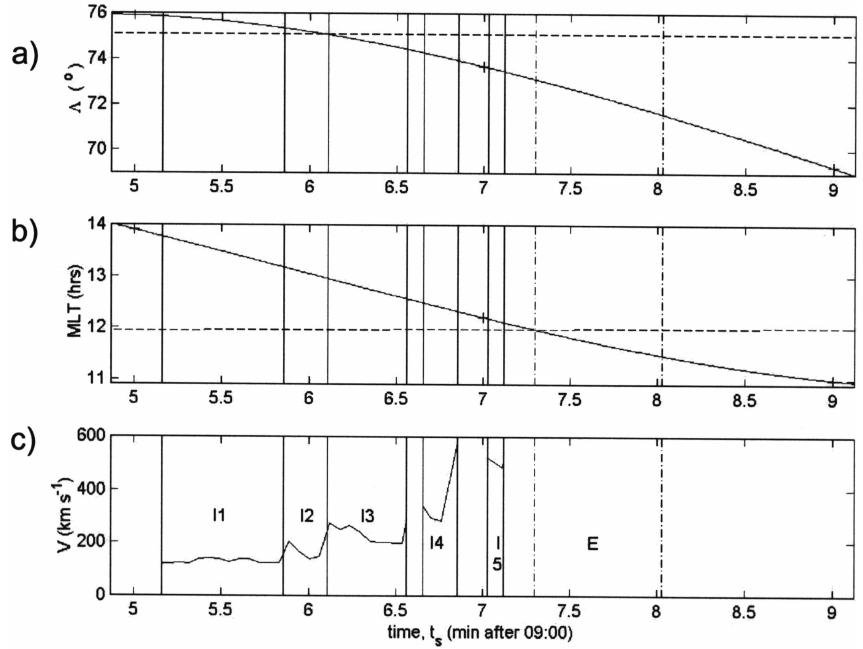
Fig. 11. (a) The invariant latitude ( 3 ) and (b) the Magnetic Local Time (MLT) of the DMSP-F12 satellite dur- ing the cusp intersection. The cor- responding values for the ESR field- aligned beam are given by dashed lines and the crosses refer to the tick marks on the relevant section of the spectro- grams shown in Fig. 5. (c) the cutoff ion velocity, V , of cusp ions. Ion events between steps I1, I2 and I3 are contigu- ous, whereas I4 and I5 form isolated patches. The dispersed disappearance of BPS electrons is labelled as event